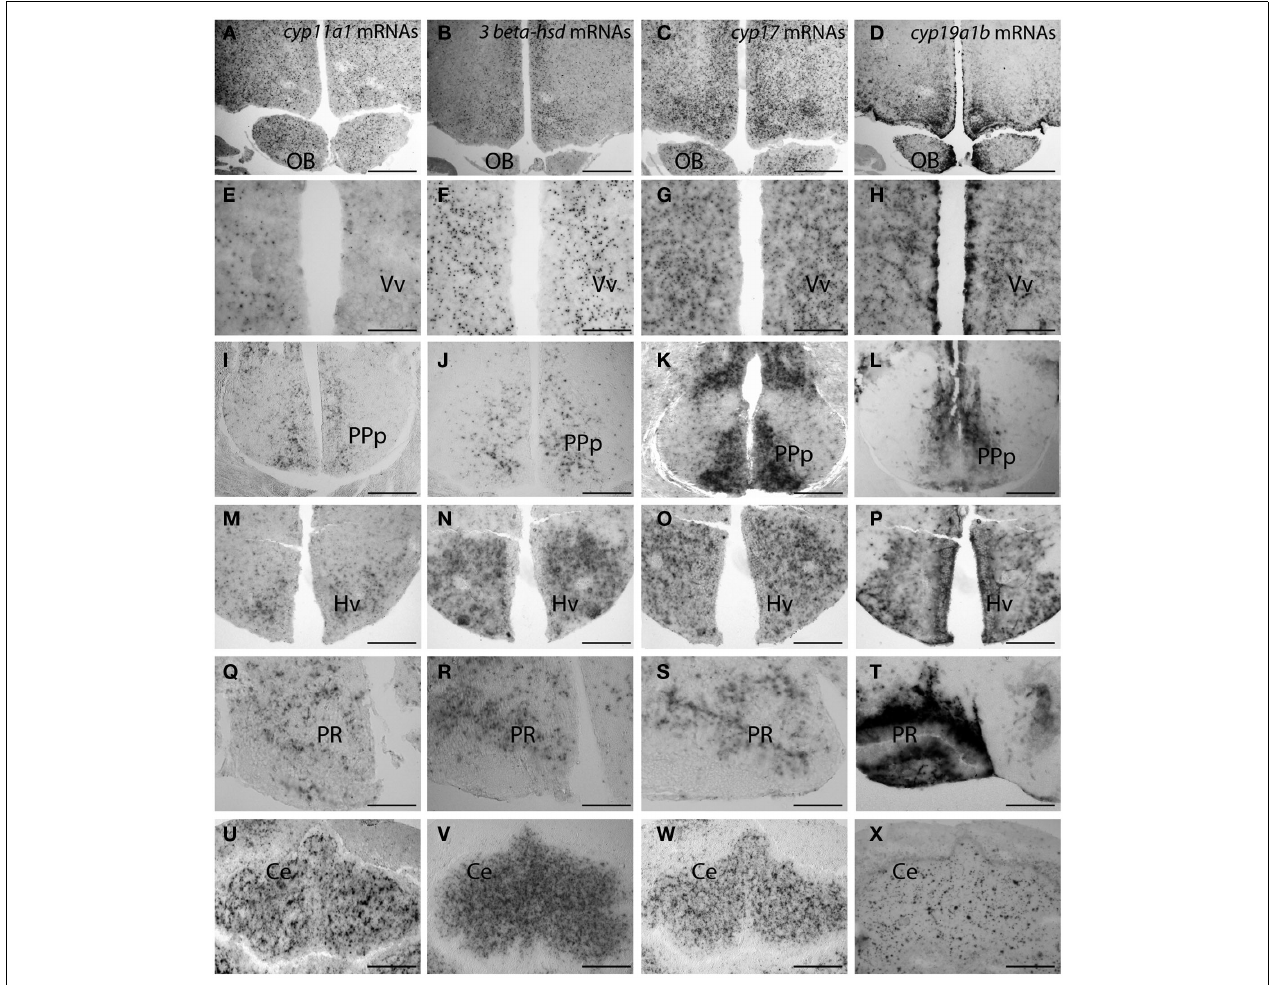
(M–P) , in the nucleus of the recessus posterioris (Q–T) , and in the cerebellum (U–X) . Note that in (A–H) and (M–P) , hybridization was performed on parallel sections of the same brain. Ce, cerebellum; Hv, ventral zone of the periventricular hypothalamus; OB, olfactory bulbs; PPp, posterior part of the preoptic area; PR, posterior recess;Vv, ventral nucleus of the ventral telencephalic area. Scale bars: 80 μ m in A, B, C, D, I, K, M, N, O, and P; 40 μ m in J, L, U,V,W, and X; 20 μ m in E, F, G, and